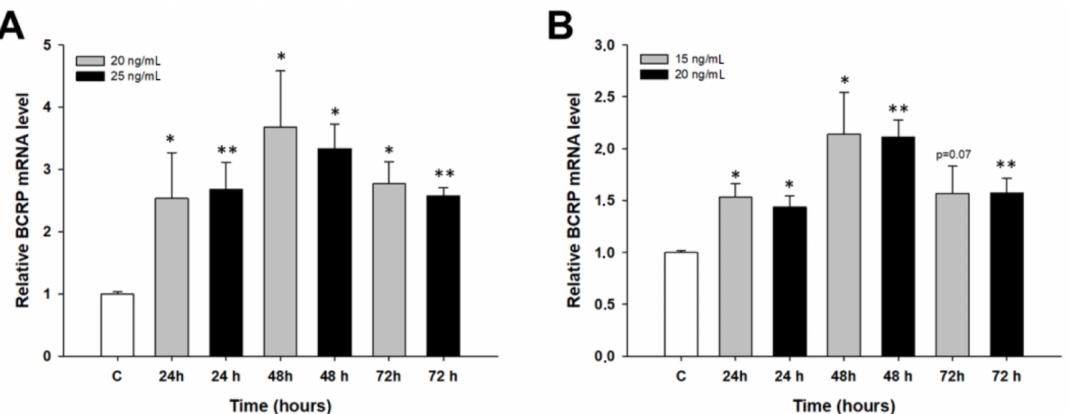
Figure 6. Expression analysis of the BCRP gene in the A2780 ( A ) and W1 ( B ) cell lines. The figure presents the relative gene expression in the PAC-treated cells (grey and black bars) with respect to that in the untreated control (white bars), which was assigned a value of 1. The values were considered significant at * p < 0.05 and ** p < 0.01.